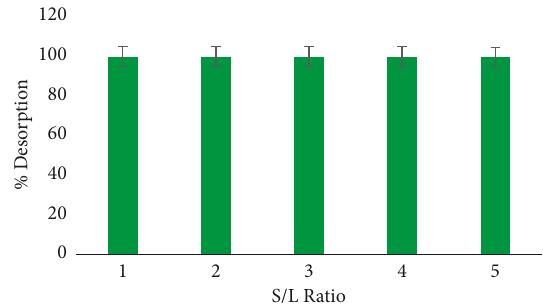
Figure 9: Desorption efficiency of RO16 for varying solid-to-liquid ratio.